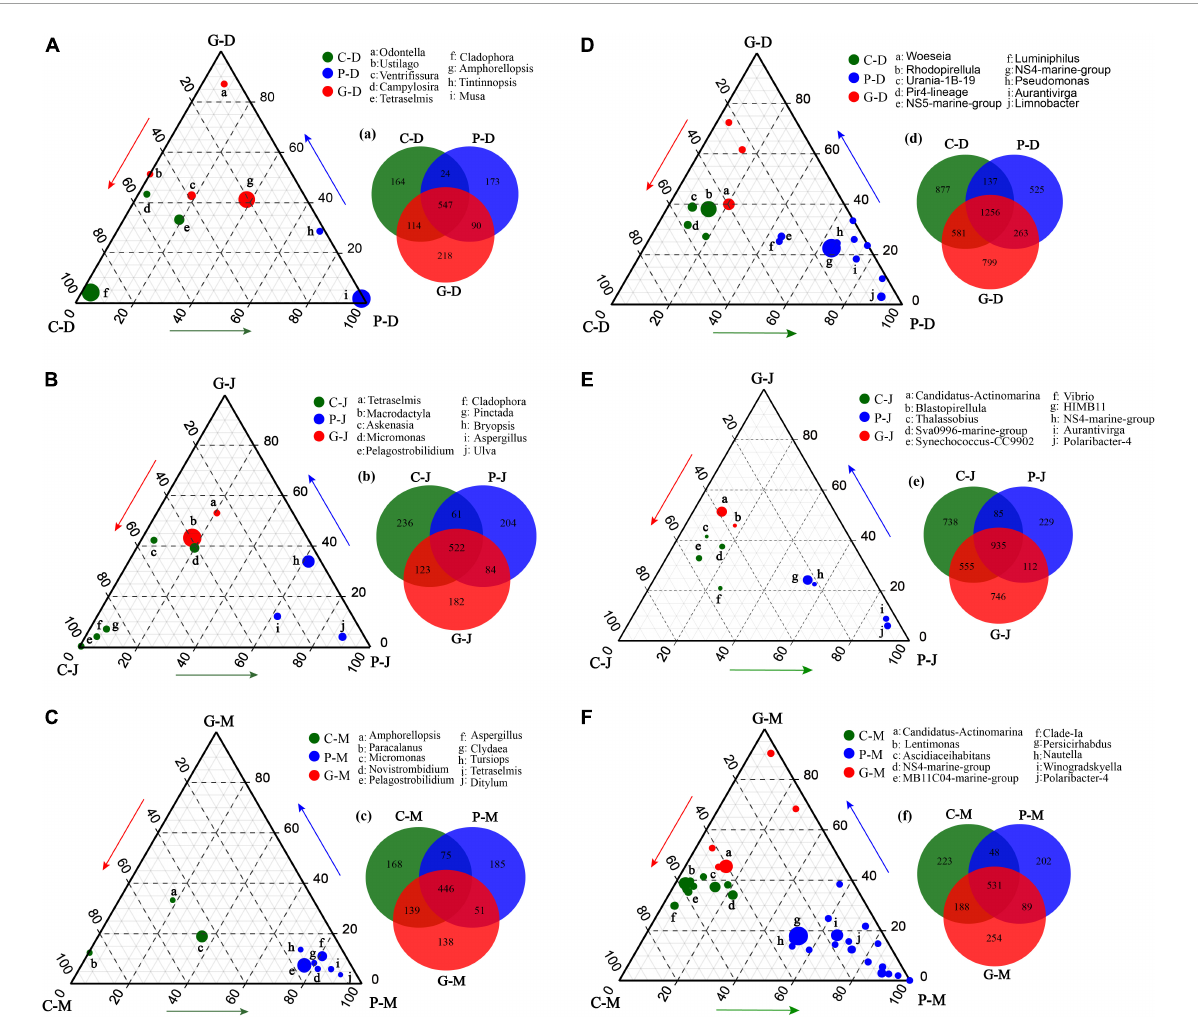
FIGURE5 Ternary plot derived from all studied zones and periods based on 18S (A–C) and 16S (D–F) , and numbers of differentially enriched OTUs among different sampling zones (a–g). Ternary plots of the 10 most abundant genera in seawater. For each plot, the group was taken into consideration, and a density area was drawn to represent similarity within groups. Each circle represents one genus. The size of each circle represents its relative abundance. The position of each circle is determined by the contribution of the indicated compartments to the total relative abundance. Green, blue, and red circles mark genera significantly enriched in zones C, P, and G, respectively ( p -value < 0.05). The endpoints of each ternary plot represent the sampling zones of their respective periods, and the arrows indicate the direction of the